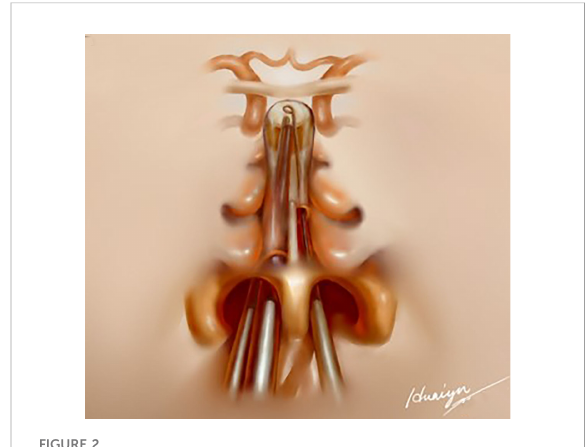
FIGURE 2 Schematic illustration of endoscopic 1½-transseptal approach.